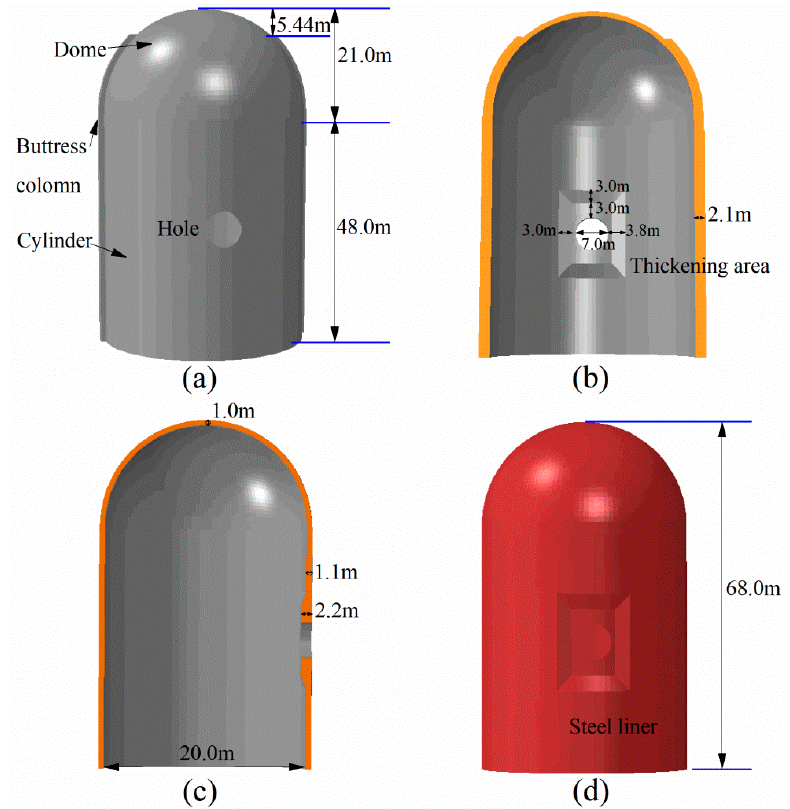
Figure 1. Schematic of the containment and steel liner: ( a ) 3D view of the whole structure; ( b ) x-profile; ( c ) y-profile; ( d ) 3D view of steel liner.